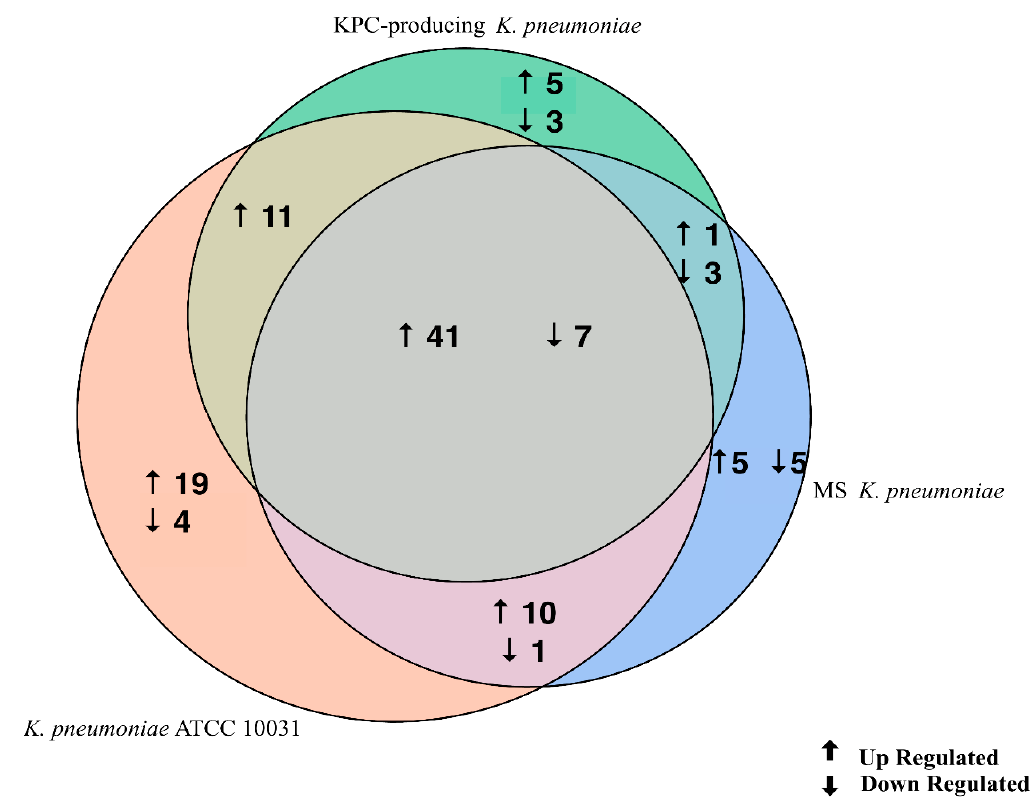
Figure 3. Venn diagram of di ff erentially expressed miRNAs in three samples. The Venn diagram shows the di ff erent expressions of miRNAs after exposure of BEAS-2B cells to OMVs purified from three di ff erent strains of K. pneumoniae (ATCC 10031, MS and KPC-producing) compared to the control sample. The numbers in the intersecting circles represent the miRNA sequences commonly dysregulated in the di ff erent samples.